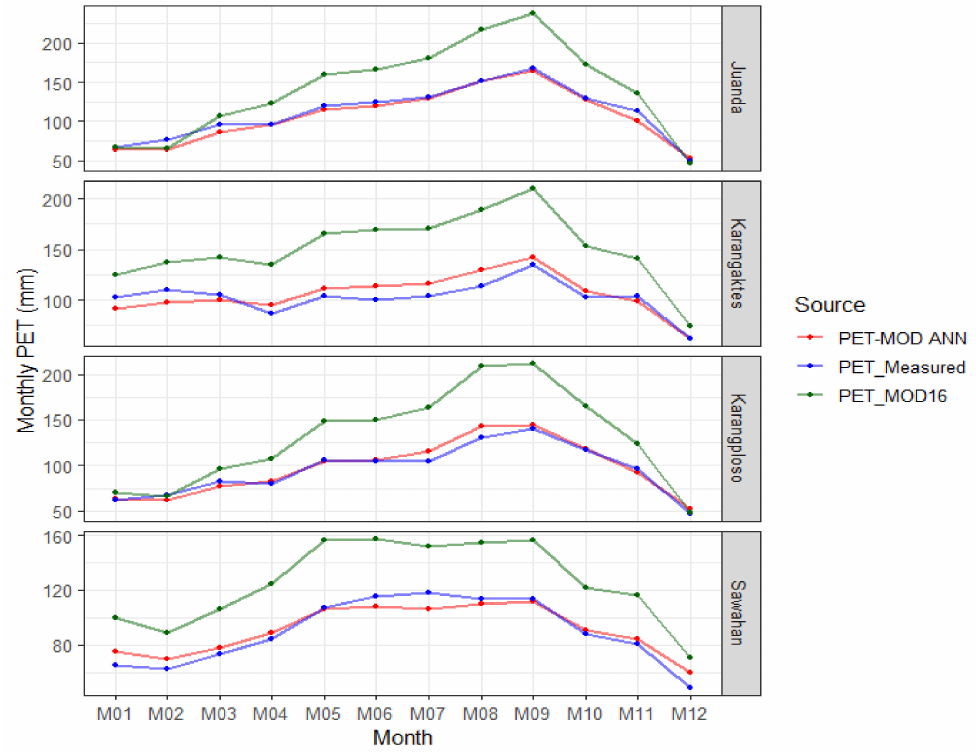
Figure 5. Monthly PET patterns from native MODIS-16 PET (PET_MODIS), ANN-PET (PET_MOD ANN), and measured PET at four weather locations